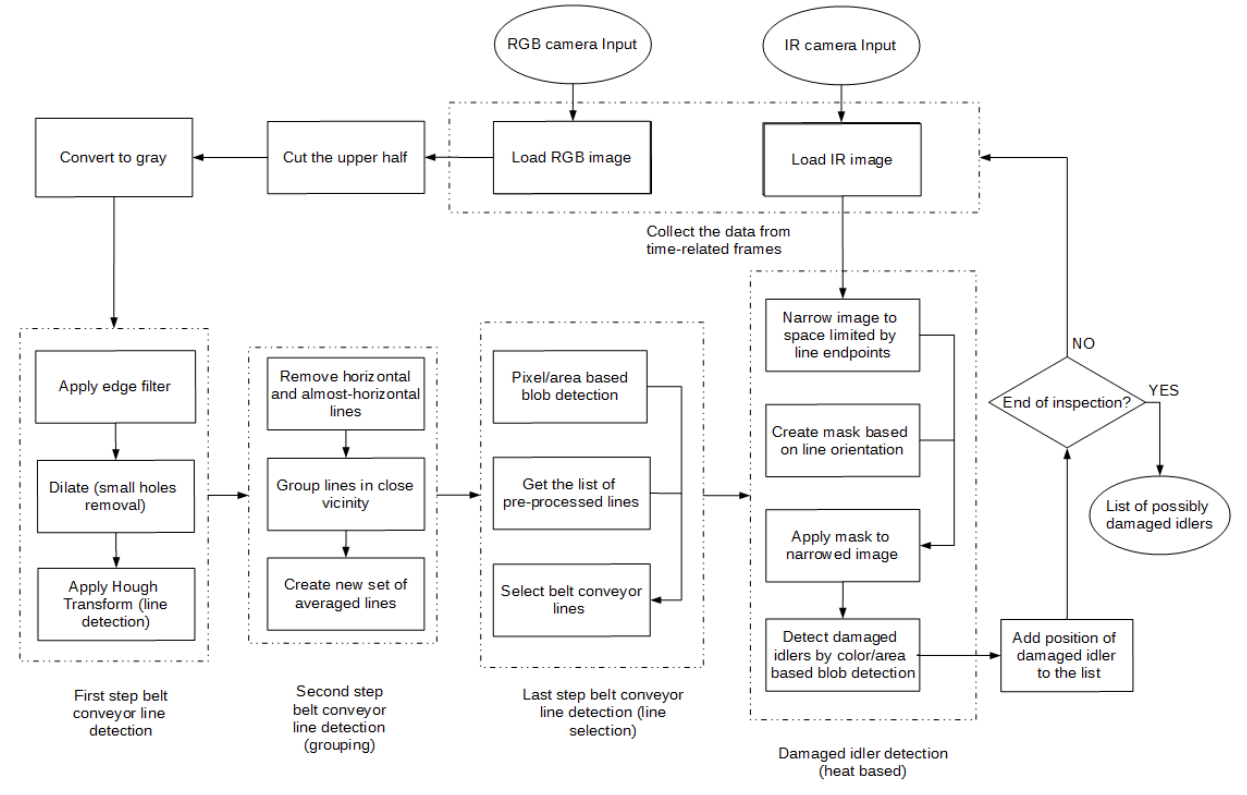
Figure 5. Simplified flowchart of